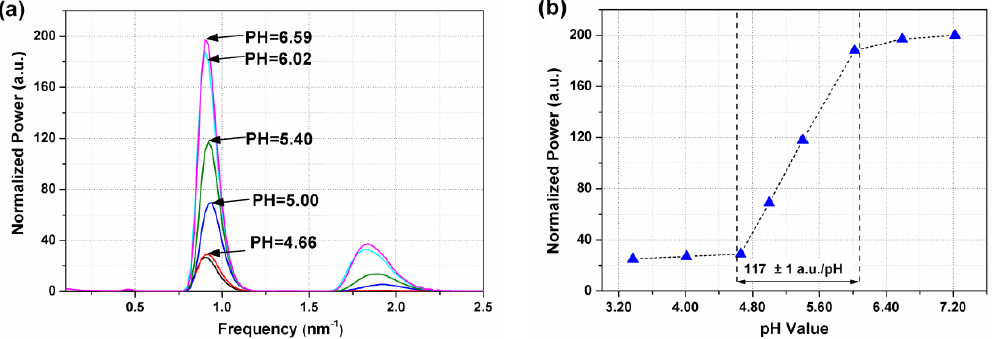
Figure 8. ( a ) Corresponding FFT spectra of TFBG pH sensor with (PDDA/PAA) ( b ) The peak amplitude around 0.8 nm −1 changes with the pH of the solutions.